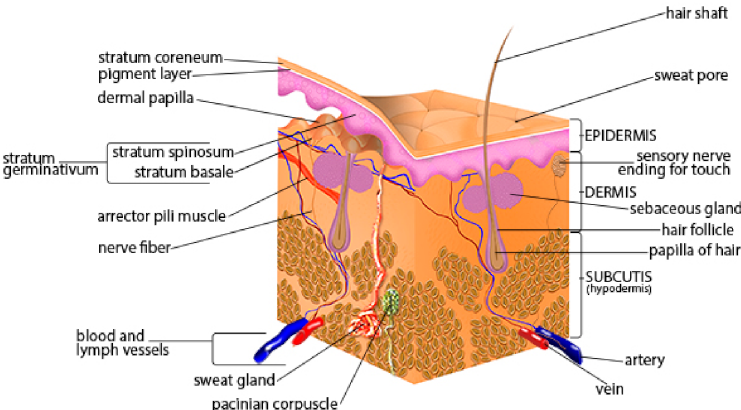
Figure 2. Schematic of human skin anatomy [9]. Reproduced with permission from SEER Train- ing Modules, Skin Cancer: Melanoma; published by U.S. National Institutes of Health, National Cancer